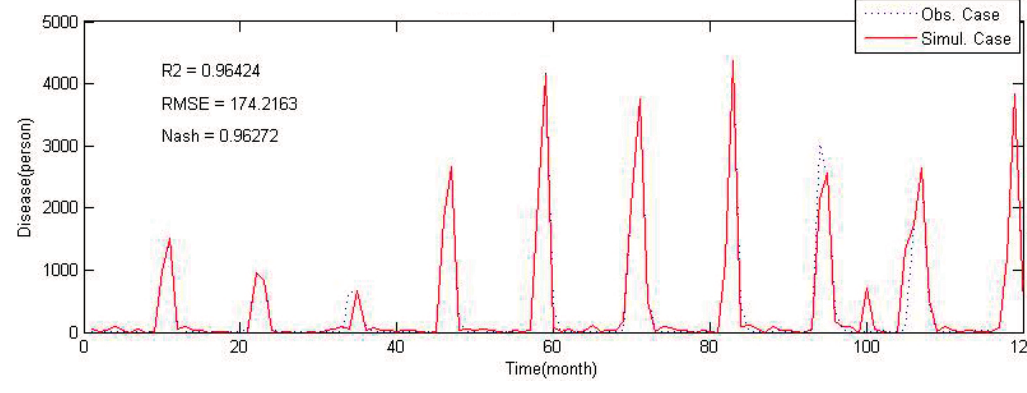
Figure 7. Calibration results of scrub typhus incidence model.